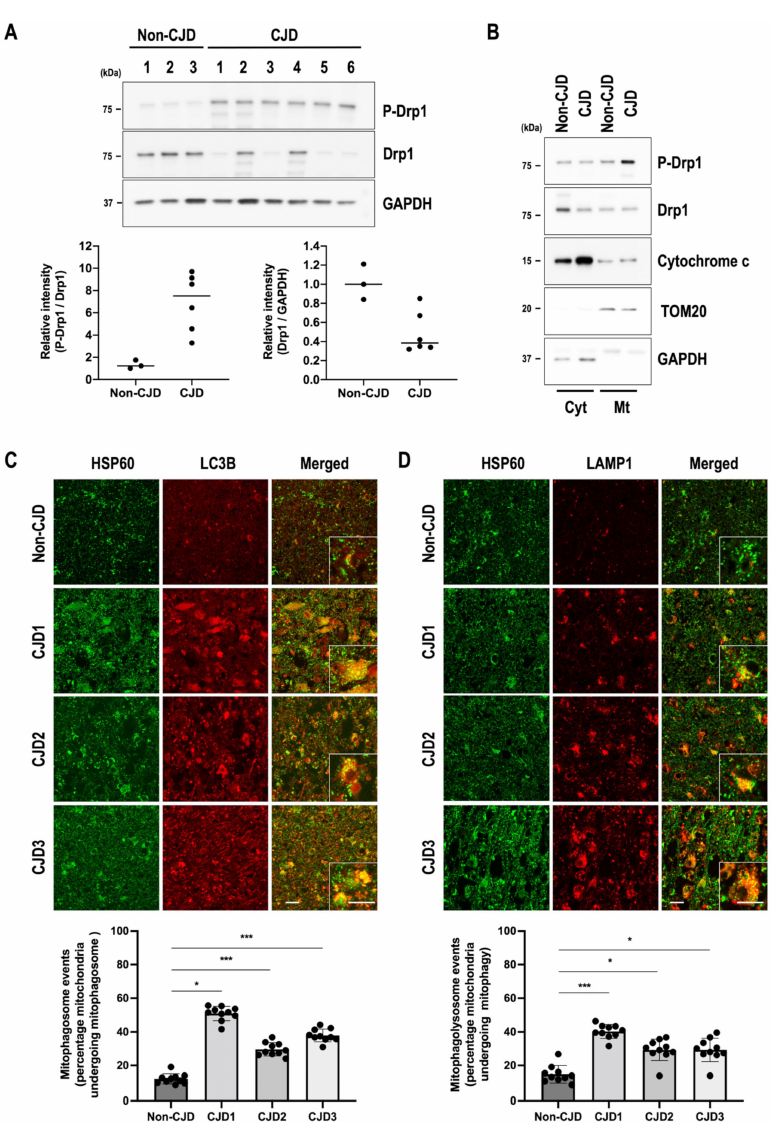
Figure 6. Prion disease induces neuropathogenesis via mitochondrial quality control dysfunction. ( A ) Expression levels of P-Drp1 and total Drp1 in the frontal lobe of non-CJD and sCJD patients were evaluated using Western blotting. ( B ) Mitochondrial localization of P-Drp1 in the cytosolic (Cyt) and mitochondrial (Mt) fractions was analyzed by Western blot analysis. TOM20 and GAPDH were used as markers of the mitochondrial and cytosolic fractions, respectively. ( C , D ) The colocal- ization of HSP60 (green) with LC3B (red) and LAMP1 was determined using confocal microscopy. Quantification of mitophagosome ( C ) and mitophagolysosome ( D ) formation was analyzed using EzColocalization plugin for ImageJ software version 1.53a ( n = 9 random fields from non-CJD and 3 sCJD patients; *** p < 0.001, * p < 0.05; one-way ANOVA with Tukey’s post hoc test), n = number of random selected fields from 3 CJD patients or 1 non-CJD control. Enlarged inset (white line boxes) showed the sections at a higher magnification, scale bar, 20 µ m. Bullets in bar graph represent